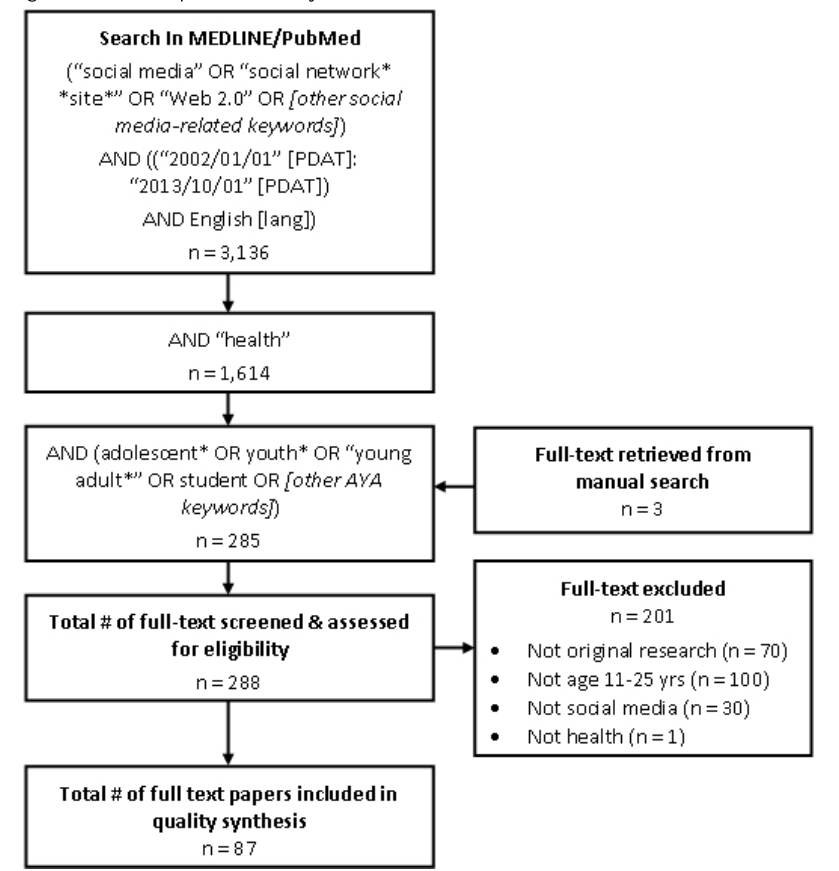
Figure 1. PRISMA flow diagram of selection procedure for systematic review.